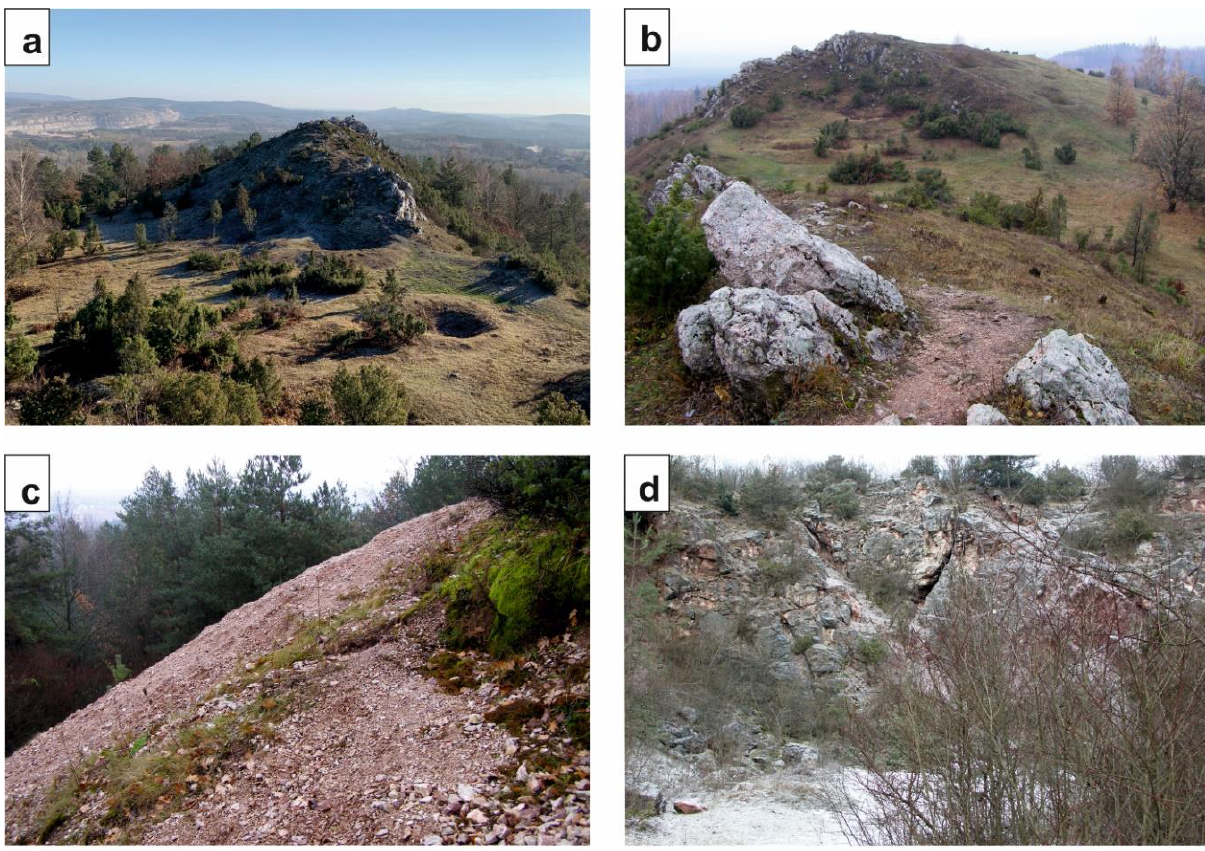
Figure 3. Cont. Figure 3.